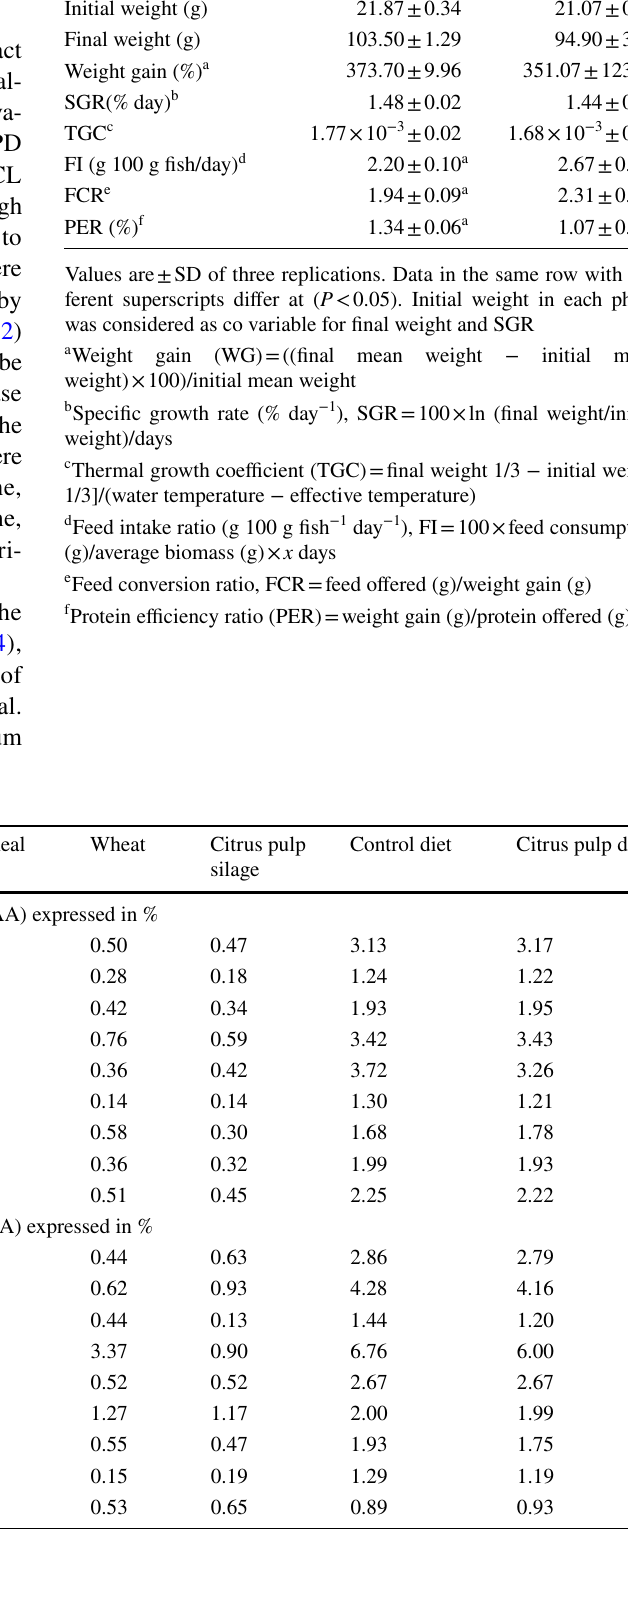
Table 4 Growth and feed efficiency parameters on sharpsnout sea bream fed with the two experimental diets at the end of the trial